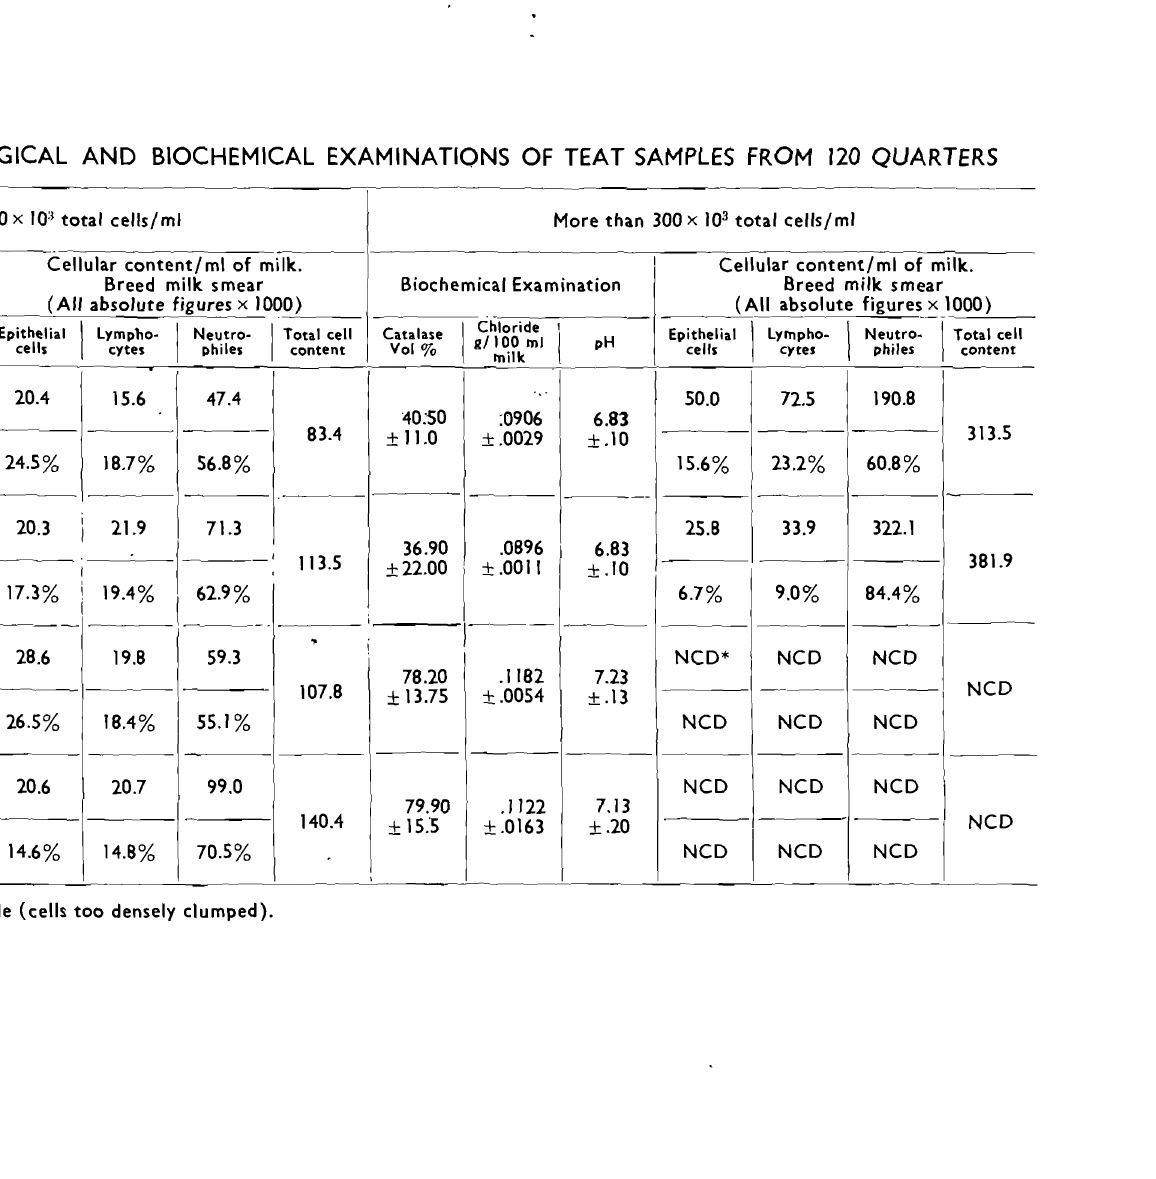
Breed milk smear